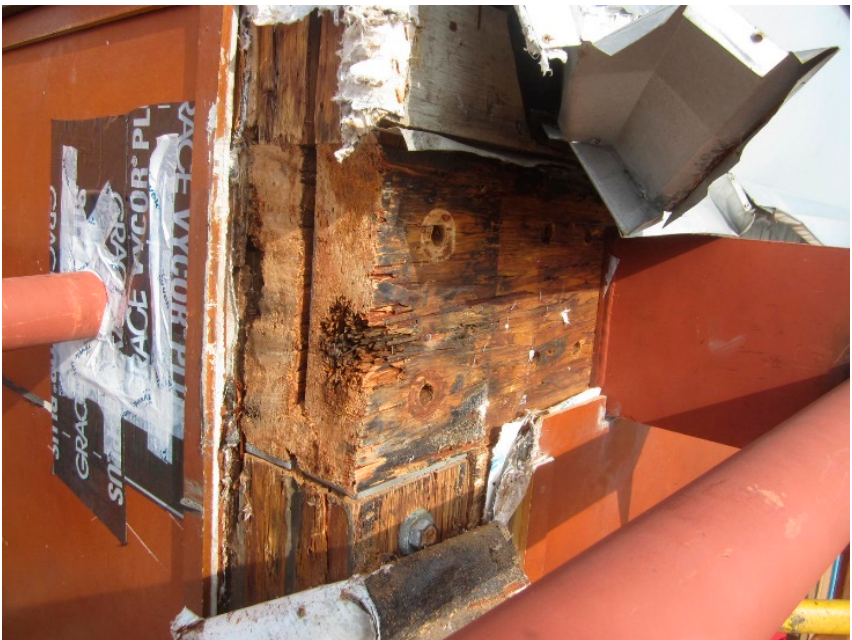
Figure 6. Moisture ingress and decay in a typical engineered wood structural member. Photo: Wiss Janney Elstner, Inc.